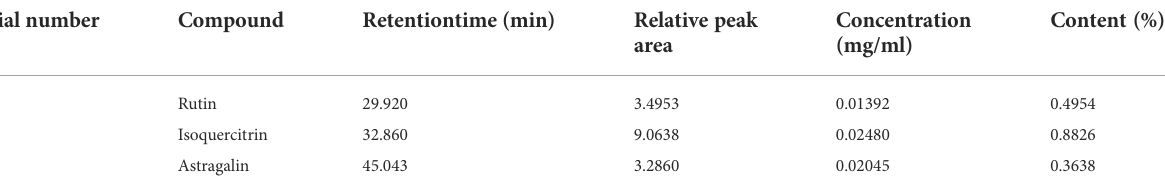
TABLE 1 Determination of rutin, isoquercitrin and astragalin contents in MLFs by HPLC